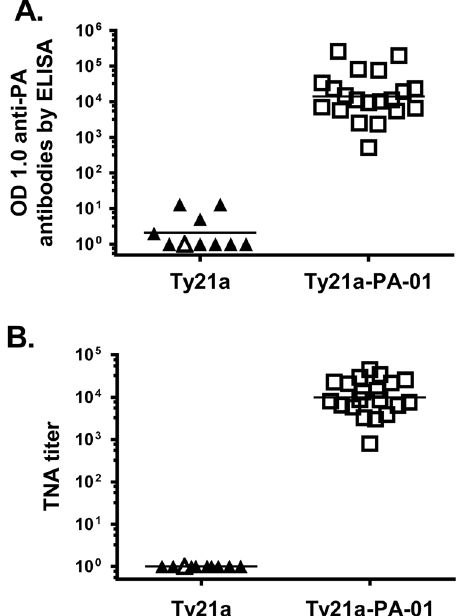
Fig. 1 Antibodies in mice immunized with Ty21a-PA01. Mice were vaccinated with 5 × 10 7 CFU of Ty21a ( triangles ) or Ty21a-PA-01 ( squares ) by intraperitoneal (IP) injection at 2-week intervals. Sera collected at 2 weeks after dose 3 were assayed for anti-PA IgG by ELISA ( a ) and anthrax toxin neutralization activity (TNA) ( b ). Antibody responses by ELISA are reported as the serum dilution at which the optical density was 1.0 (OD 1.0), and TNA titers as the last serum dilution at which there was 50% protective activity against killing of macrophages (J774A.1) by LT. Filled symbols represent mice that were not protected in the spore challenge study and open symbols represent those that were protected (see Fig. 3). The geometric mean of each group is shown as a horizontal line. Antibody responses between the two groups were analyzed by Mann – Whitney U test ( p = 1.1 × 10 − 5 and 8.2 × 10 − 6 for ELISA and TNA,